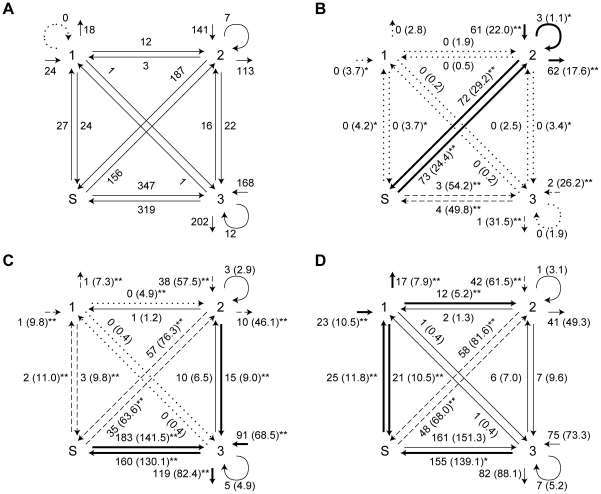
State transitions of USV calls and behavior.(A) Four-state transition model. The states correspond to three clusters (1, 2, and 3) and silence (S). The numbers bordering the arrows are frequencies for the transition. (B), (C), and (D) show frequencies for transitions in feeding, moving, and fighting. Values in parentheses indicate expected ones. Asterisks indicate results of residual analyses of clusters and behaviors (*p<.05, **p<.01), excuding repetition of cluster 1 without silence because this transition was not observed in all data. Bold arrows mean the observed value was significantly larger than expected value; dashed arrows mean the observed value was significantly smaller than expected; dotted arrows mean no transition was observed; and thin arrows mean not significant.